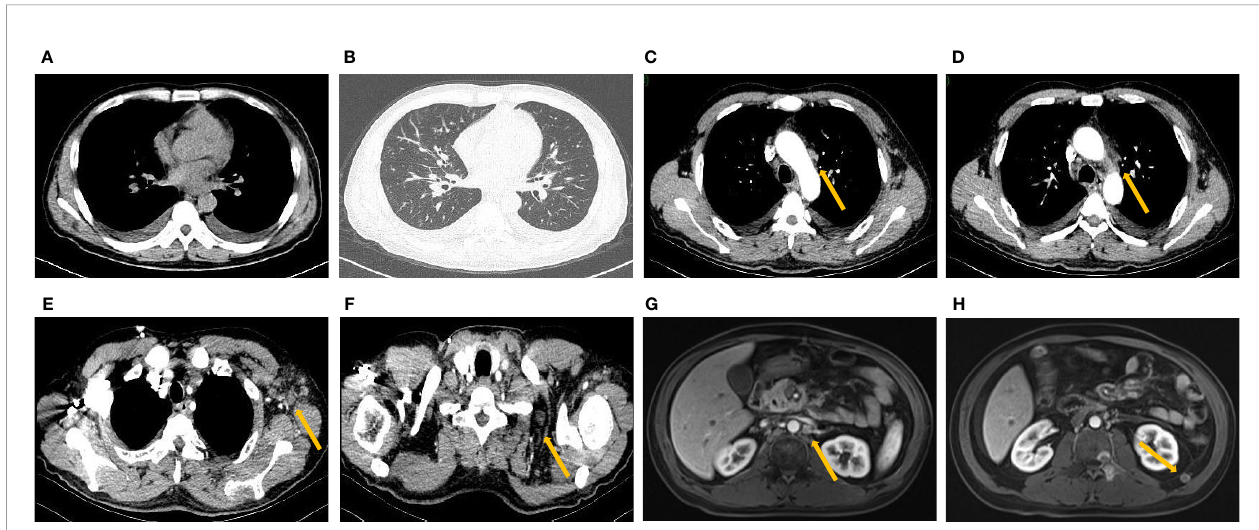
FIGURE 3 | New pleural effusion (A) and cancerous lymphangitis (B) with enlarged mediastinal (C, D) , axillary (E) and supraclavicular (F) lymph nodes on pulmonary CT after third-line treatment. Enhanced MRI of the abdomen showed enlarged retroperitoneal lymph nodes (G, H) .